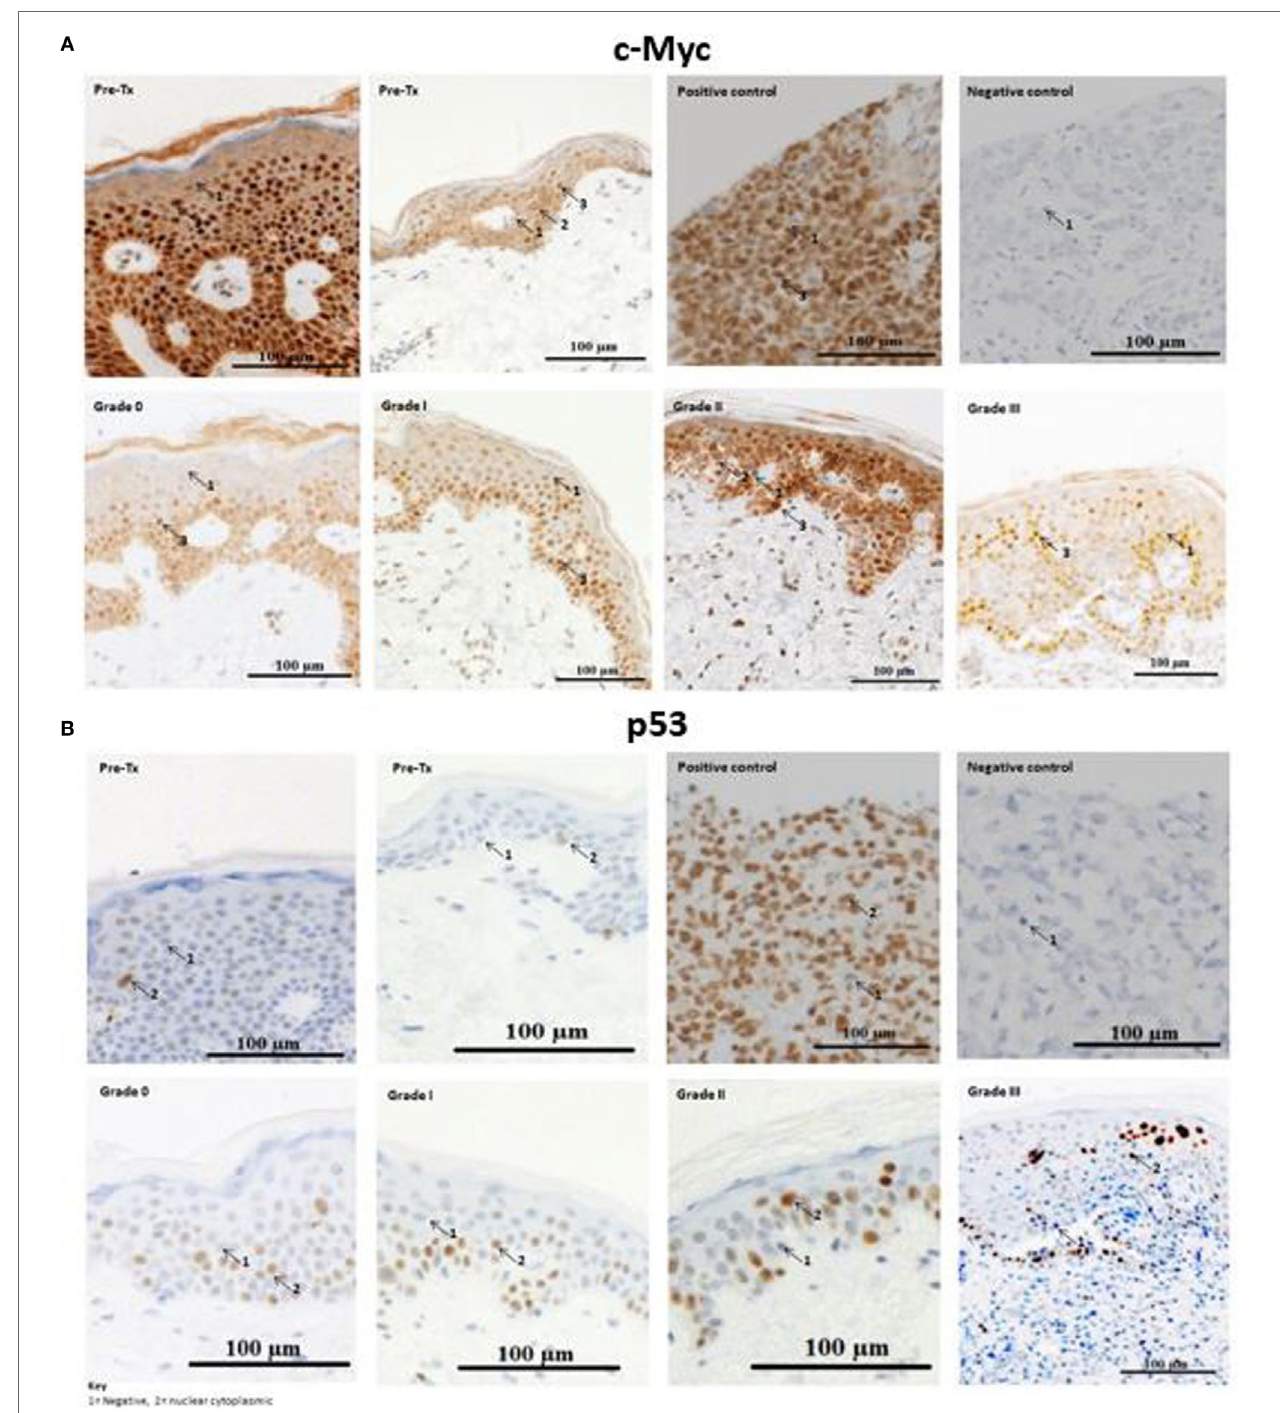
FigUre 4 | Example skin biopsy positivity for c-Myc and p53 protein. (a) c-Myc-positive cells demonstrated variable expression intensities (low, moderate, and high). No skin acute graft-versus-host disease (aGvHD) biopsies had high intensity c-Myc-positive cells in the basement membrane, while in stages 2–3 skin aGvHD positivity for c-Myc was observed throughout the entire epidermis. Positive-c-Myc proteins were also present in the pre-transplant skin biopsies. (b) p53-positive cells were present in pre-transplant skin biopsies, but were limited in number. Strong positive staining was observed with skin aGvHD severity. (a,b) The first row shows the two pre-transplant skin sections that were taken from the individuals with cutaneous histopathological aGvHD stage 0 and stage 1 (second row), respectively. Stage 3 skin sections showed severe cutaneous aGvHD, with separation between the epidermis and dermis. For both c-Myc and p53, the number of cells that infiltrated the dermis gradually increased from no GVHD (stage 0) to severe skin aGvHD (stage 3). Breast carcinoma tissues were used as a negative and positive control for c-Myc and p53. The images were taken at 20 × magnification using AxioCamMR3.